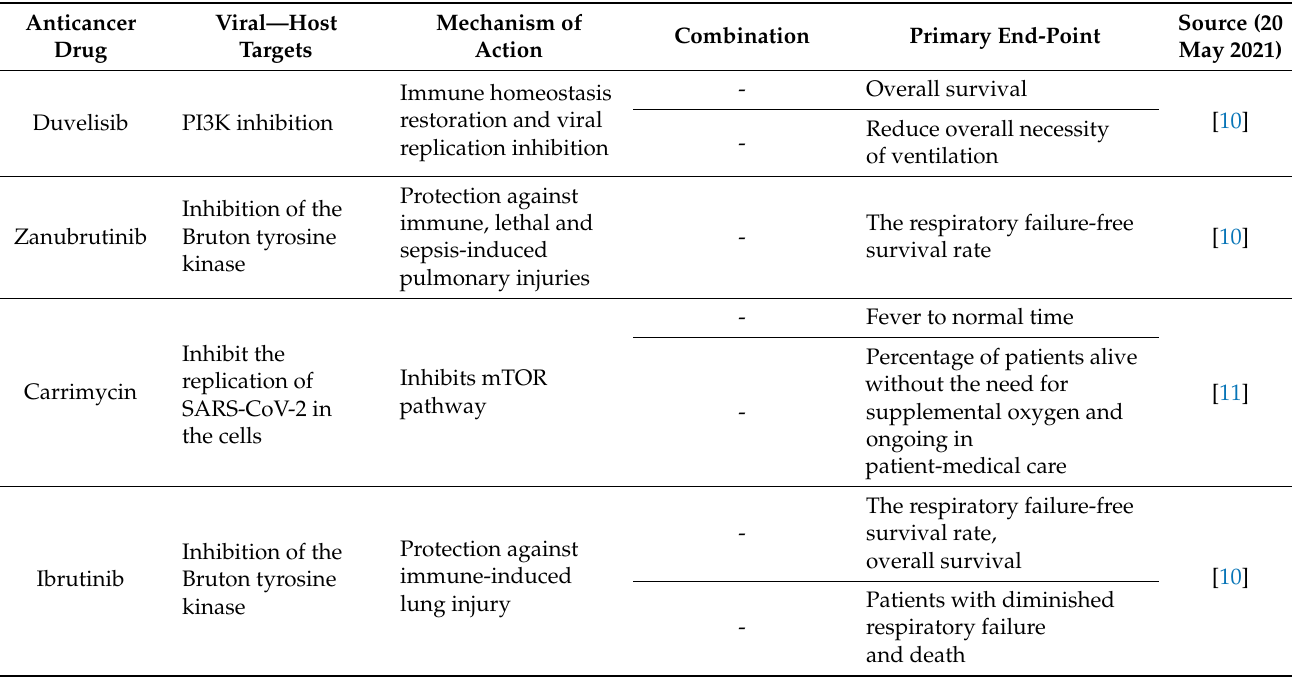
Table 6. Anticancer drugs in clinical trials for COVID-19: Blockade of kinase